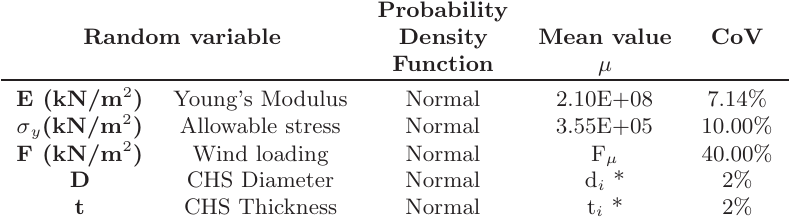
Table 3. 3D truss tower example: characteristics of the random variables.